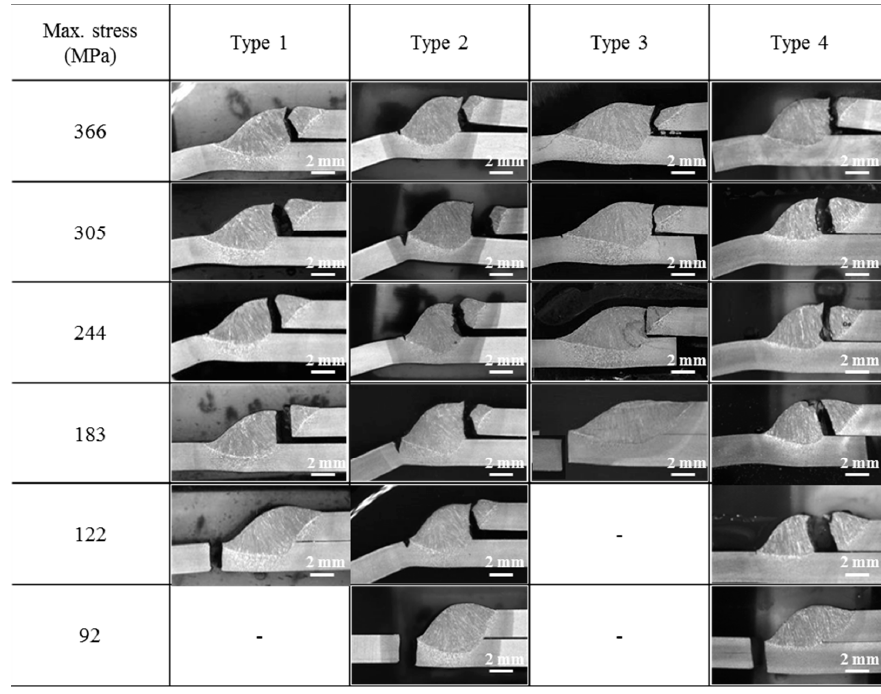
Figure 7. Fatigue fracture with various max. stresses and weld types.